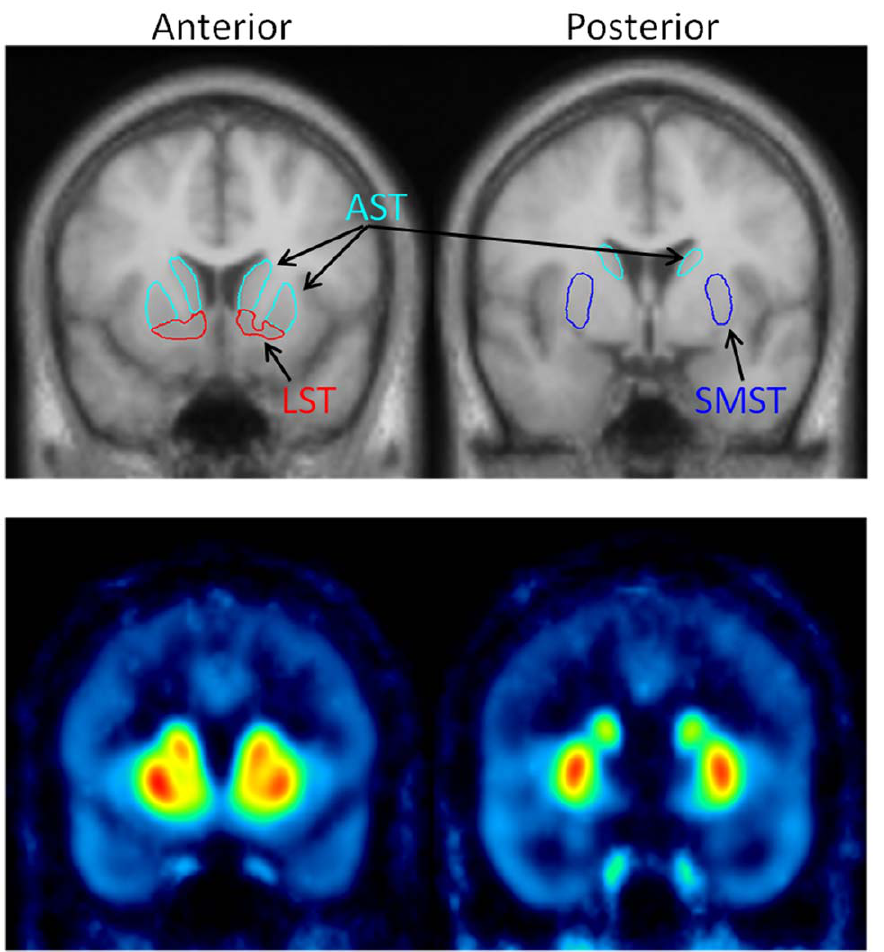
Figure 1. Definition of striatal functional subdivisions. Upper panel: MR images and regions of interest. Lower panel: parametric images corresponding to MR images in the upper panel.